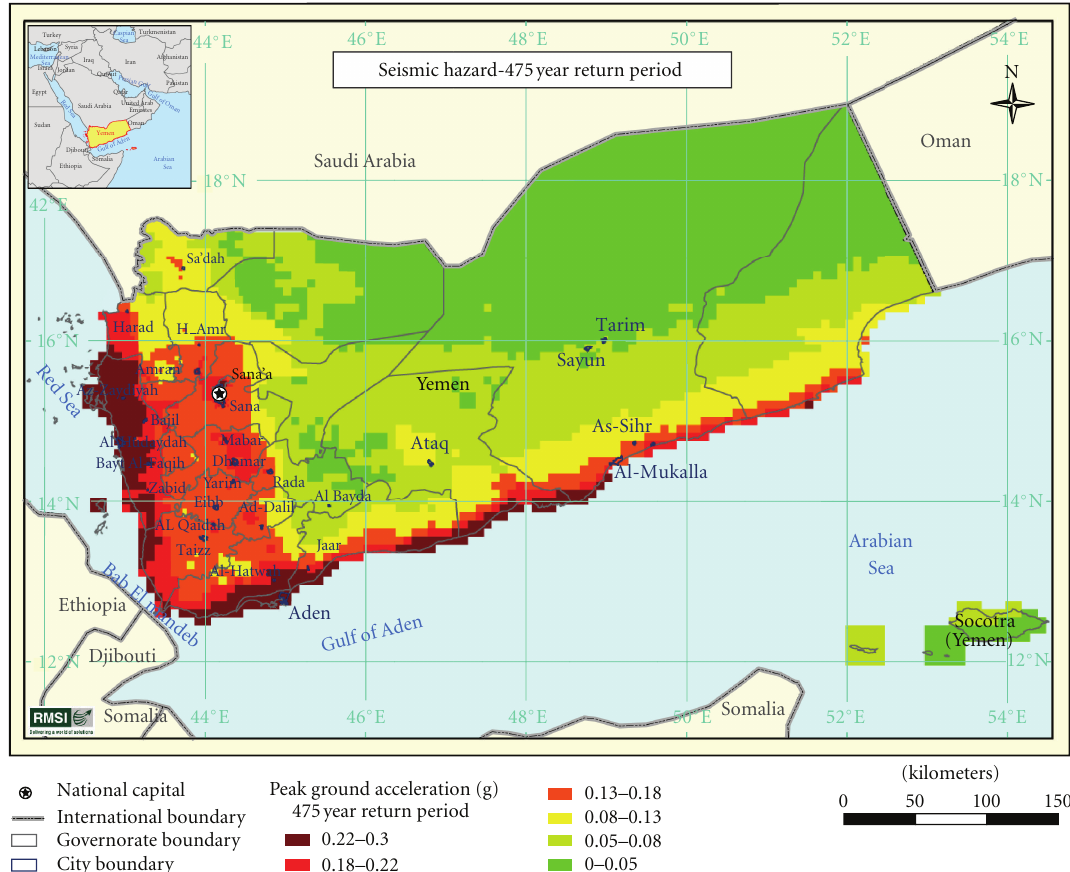
Figure 11: PGA probabilistic seismic hazard maps for 10% probability in 50 years that is, 475-year return period.